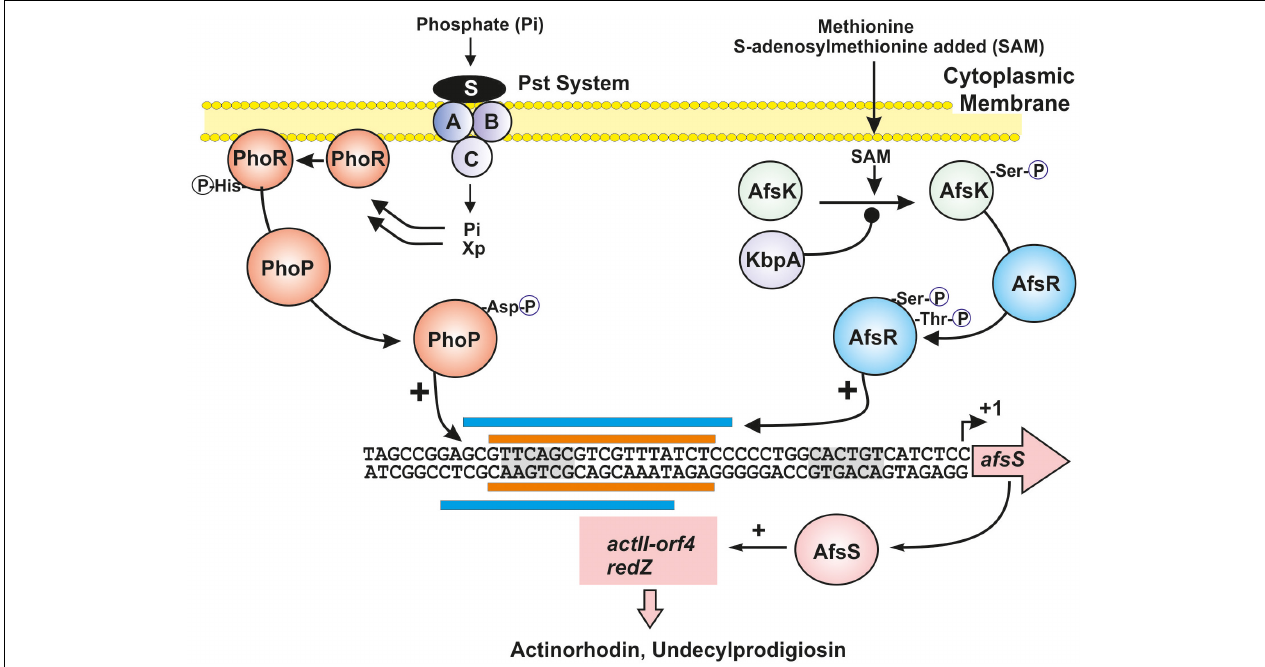
FIGURE 1 | Integration of phosphate limitation and S -adenosylmethionine signals through overlapping transcriptional factors. The TCS regulatory proteins PhoR and PhoP are shown in dark orange. Xp indicates the proposed intracellular signal in B. subtilis. The methionine signal transduction cascade through AfsK (green sphere) and AfsR (blue sphere) is shown at the right site; KbpA (purple sphere) acts as an inhibitor of AfsK phosphorylation. The sites for PhoP and AfsR binding, in the region upstream of the afsS gene, are shown with orange and blue bars, respectively. The -10 and -35 sites (gray shadows) and the transcription start point of the afsS gene are indicated. Positive regulation is indicated by arrows and negative regulations by black spheres. See text for additional details.